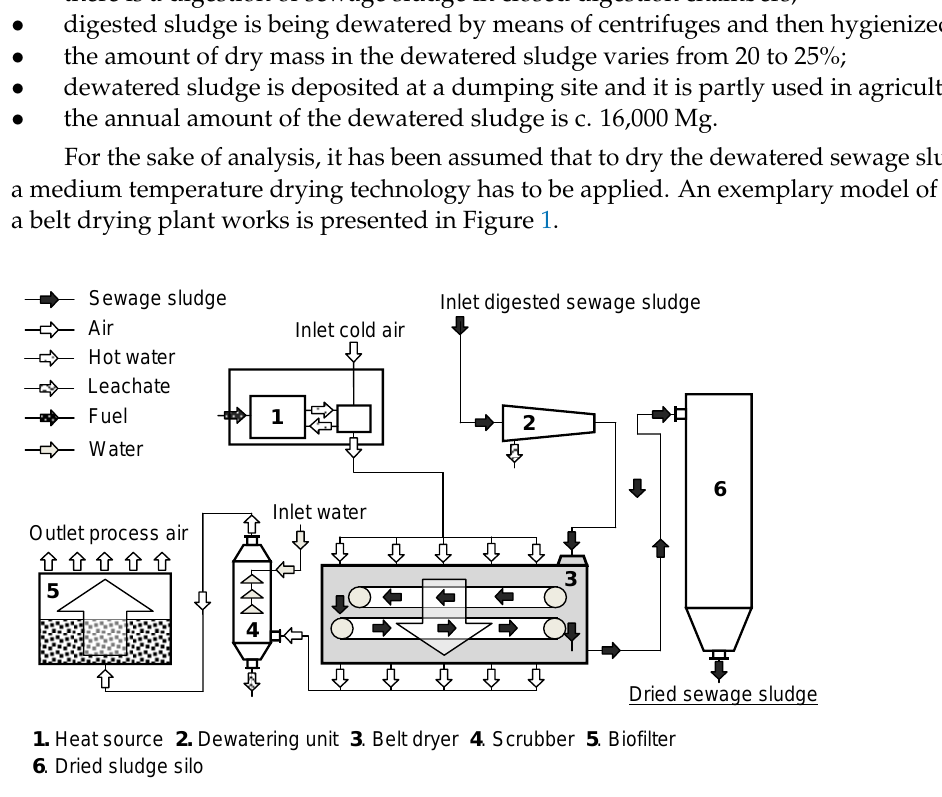
Figure 1. Process diagram of drying in a belt sludge dryer integrated with a digested sludge dewatering station .